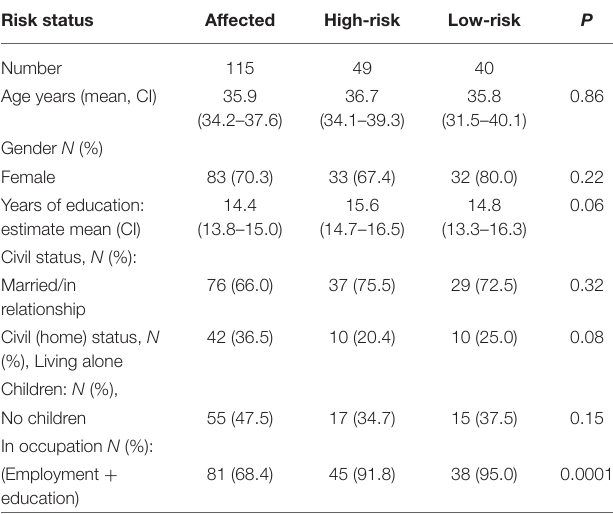
TABLE 3 | Risk status and socio-demographic variables; affected, high-risk and low-risk monozygotic twins.